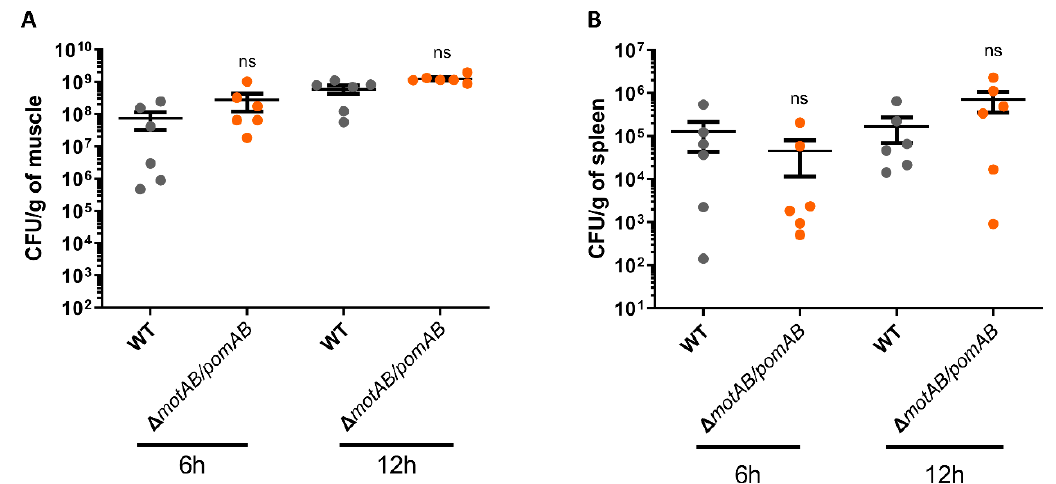
Figure 4. Bacterial proliferation in the host independent from motility. Bacterial burdens in the muscle tissue ( A ) and spleen ( B ) of mice s.c.-inoculated with WT and Δ motAB / pomAB calculated as CFU/g at 6 h and12 h post-infection. Each symbol represents an individual mouse ( n = 6/group). Error bars indicate SEM. ns, not significant ( p > 0.05) compared with WT; Mann–Whitney U -test.